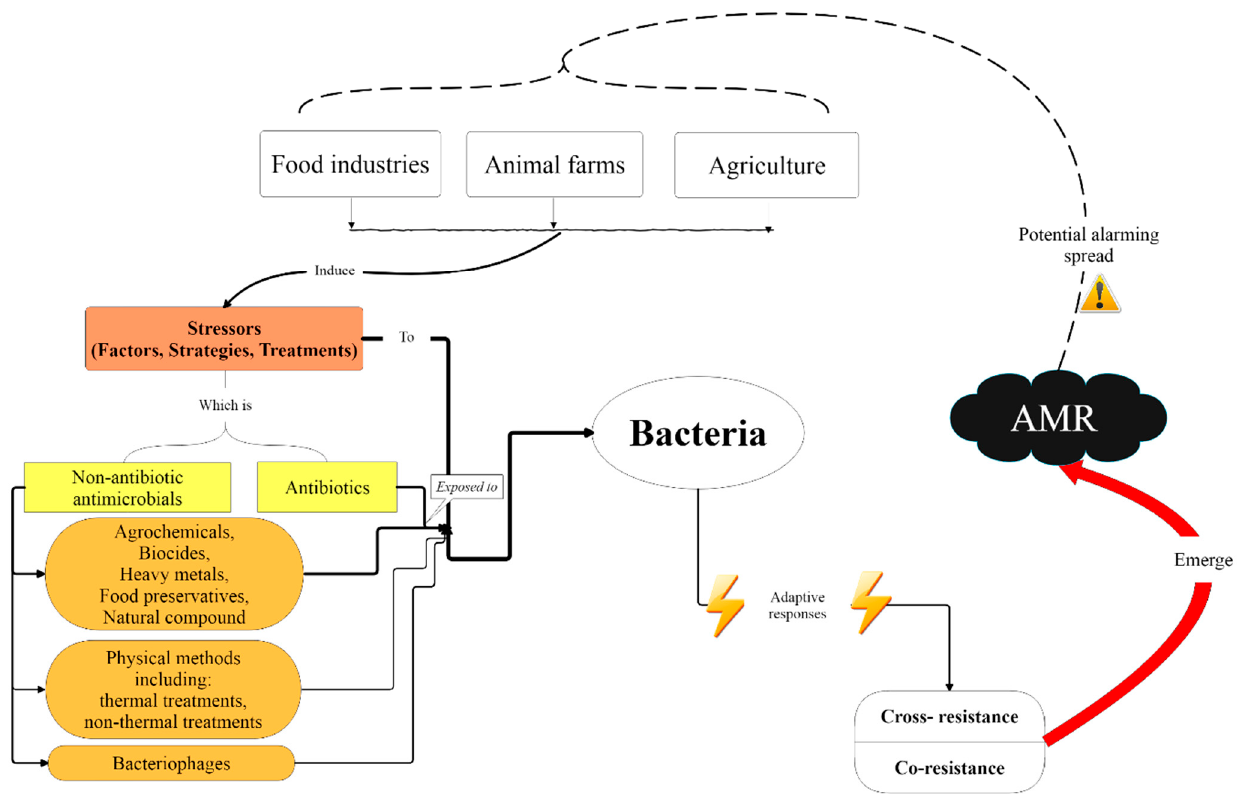
Figure 1. Schematic overview of factors contributing to bacterial adaptative responses. AMR: antimicrobial resistance.